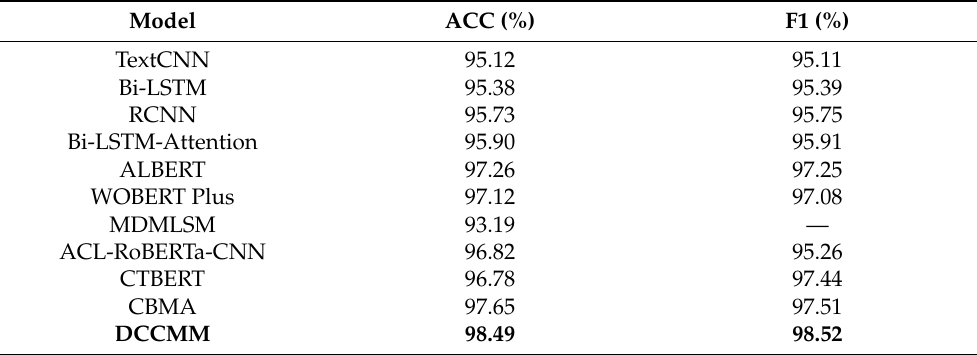
Table 4. Performance comparison of different models on the weibo_senti_100k dataset.